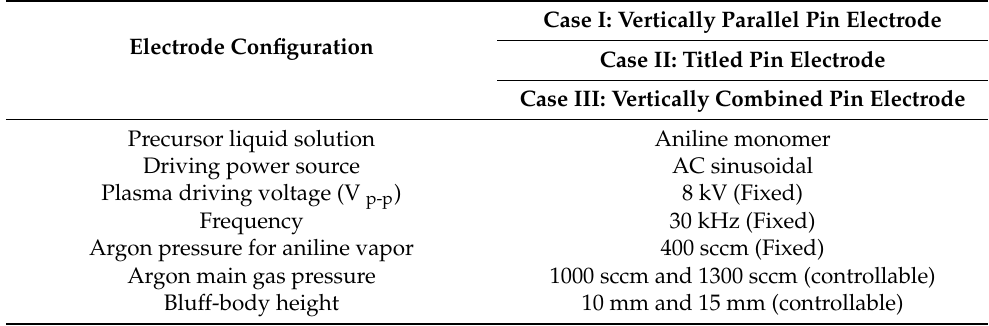
Table 1. Detailed case studies for generating the intense glow-like discharge using APPR with pin electrode used